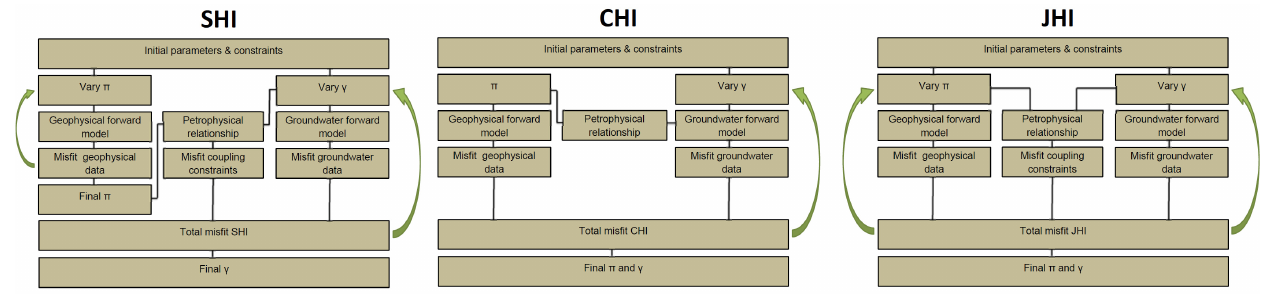
Fig. 1 SHI (left), CHI (middle) and JHI approach (right). π and γ respectively indicate the geophysical and groundwater model parameters, where the arrows represent parameter updating until a minimum data and/or constraint misfit is achieved. π : geophysical model parameters; γ : groundwater model parameters.